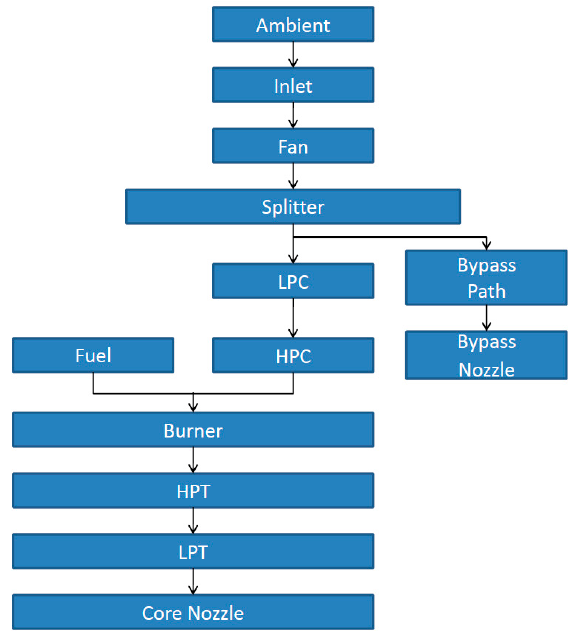
Figure 2. Layout showing various modules and their connections as modeled in the simulation.